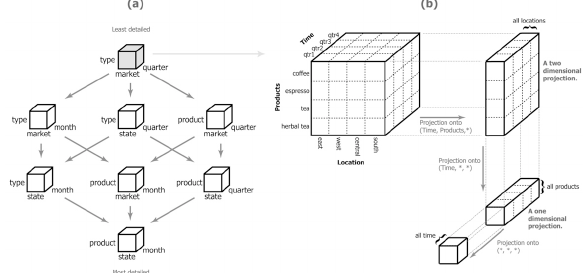
Figure 1. (a) The lattice of data cubes for a data base with three dimensions. (b) Several projections of the least detailed data cube in the lattice. (Stolte et al.)